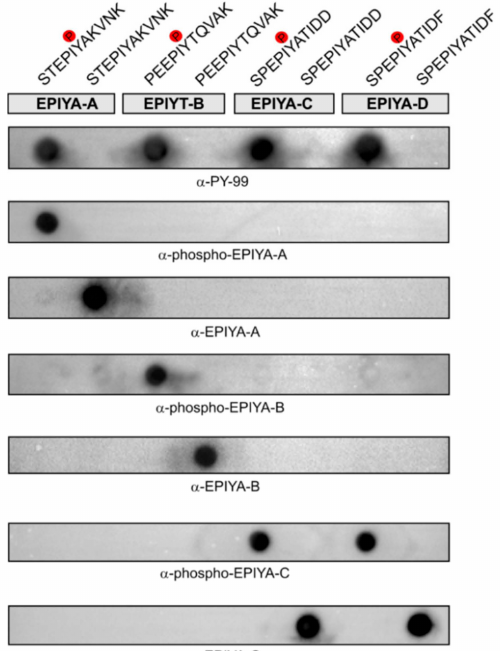
Figure 3. Specific recognition of synthetic 11-mer phospho- and non-phospho-peptides derived from the CagA EPIYA-sites A, B, C, and D by tailor-made antibodies. The indicated phospho- and non-phospho-peptides of the EPIYA-sites were synthesized and blotted onto Immobilon-P membranes using a dotblot system. The peptide sequences cover motifs representing phosphorylation sites, which can be phosphorylated by Src and Abl tyrosine kinases upon infection with H. pylori . Membranes with the indicated peptides were probed with the six antibodies generated in this study. Three independent experiments were performed with similar